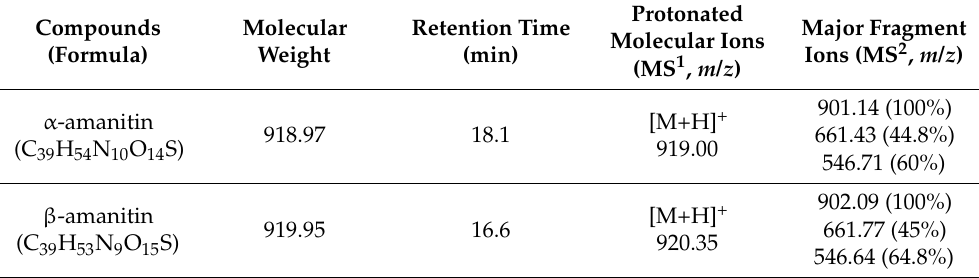
Table 6. Retention time and fragment ions of α - and β